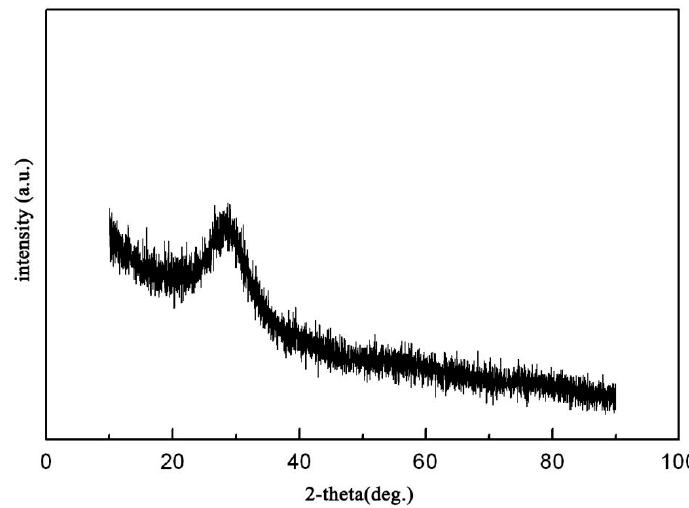
Figure 3. XRD pattern for the potassium silicate after holding at 1000 ◦ C for 96 h.